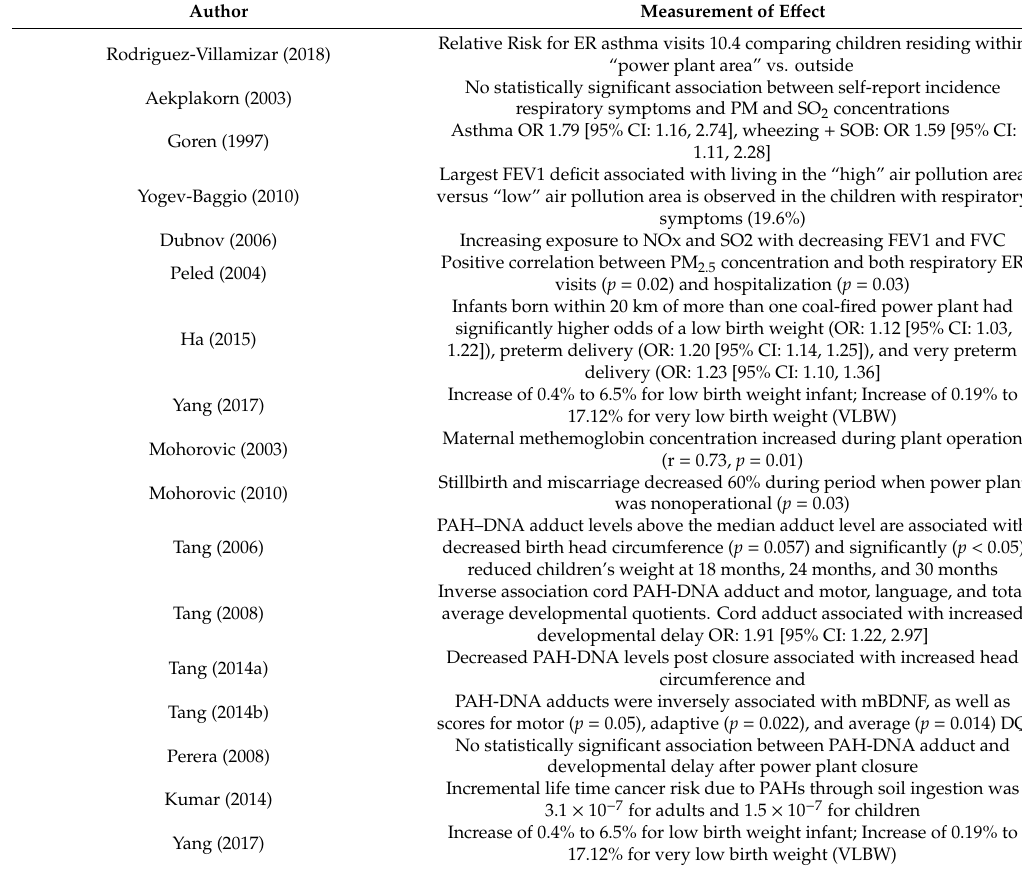
Table 3. Summary of studies’ primary e ff ect